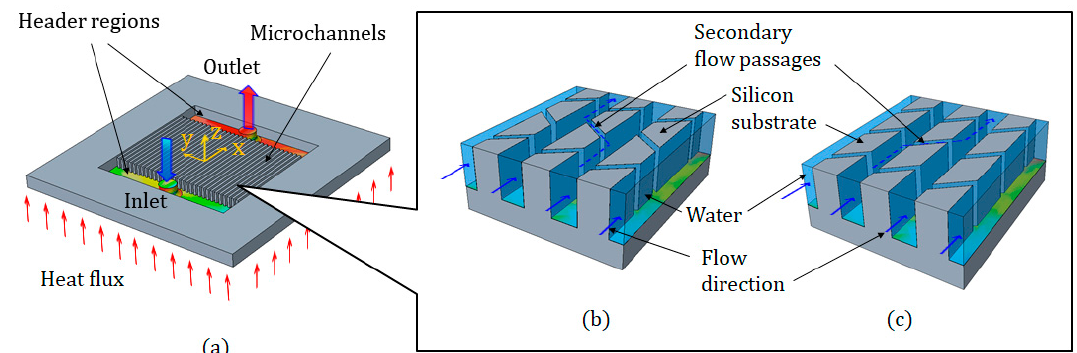
Figure 1. ( a ) Sectional view of the microchannel heat sink; ( b ) close-up view of the regular trapezoidal secondary flow (heat sink A); ( c ) close-up view of the parallel secondary flow (heat sink B).